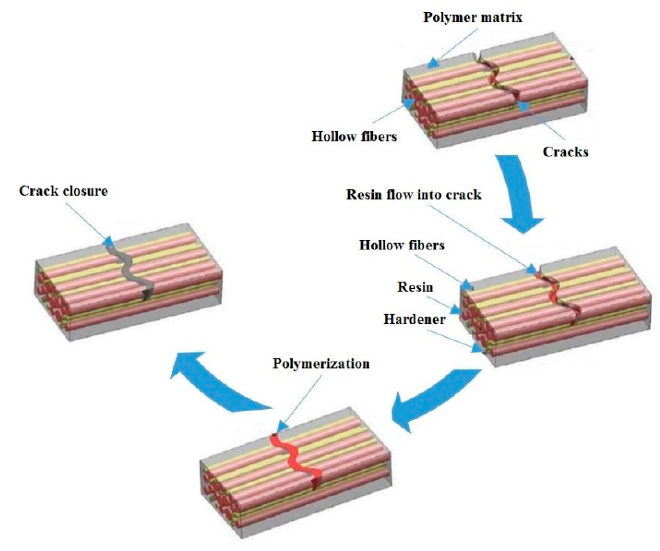
Figure 6. Schematic representation of self-healing processes using hollow fibers [58] .